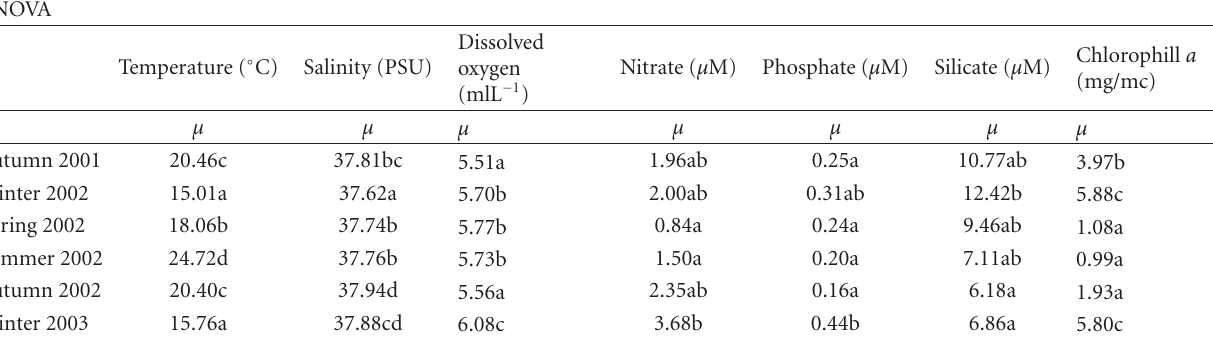
Table 2: One-way analysis of variance of seasonal variability of examinated parameters. Values in the same column with di ff erent letters are significantly di ff erent ( P < . 05) .